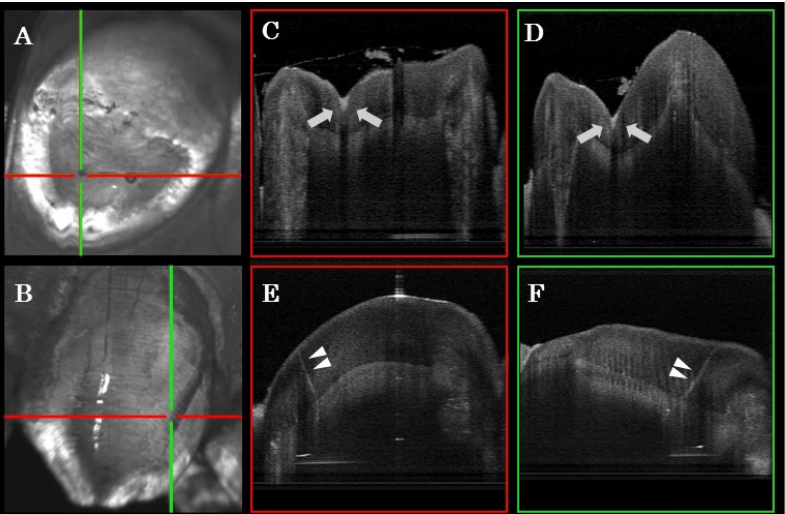
Figure 5. OCT XY en-face image of a lower premolar ( A ) and upper canine ( B ), with corresponding cross-sectional (XZ and YZ) images ( C – F ), indicated by horizontal (red) and vertical (green) lines on the en-face images. At cross point of the cross-sections of the lower premolar, a high signal intensity area at a pit and fissure part of the occlusal surface indicates early caries lesion ( C , D arrows). This pattern of scattering at the base of occlusal fissures indicates initial enamel caries lesion without surface breakdown (no cavitation). At cross point of the cross-sections of the upper canine, a fine bright line indicates crack progress extending from the enamel surface into DEJ ( E , F arrow heads).